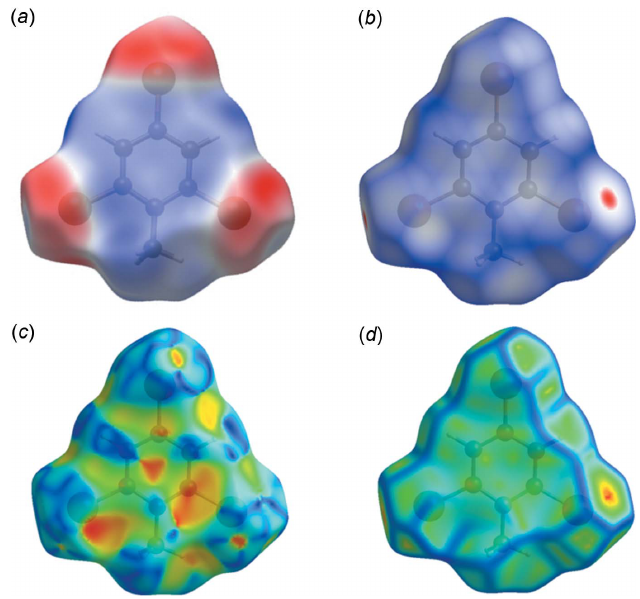
Fig. 11 c (O (cid:2) (cid:2) (cid:2) H/H (cid:2) (cid:2) (cid:2) O) shows the contact between the